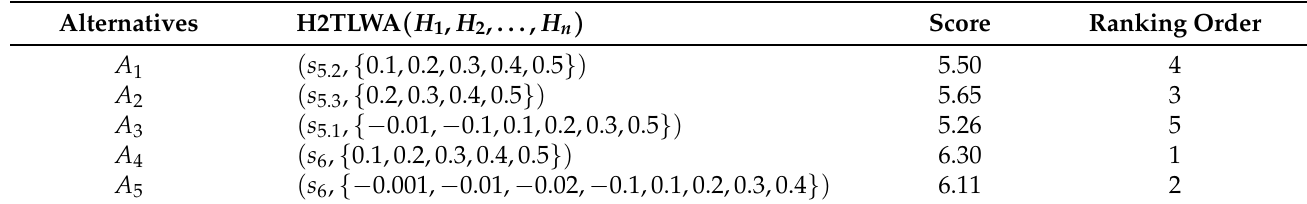
Table 5. Ranking of alternatives by using H2TLWA operator.